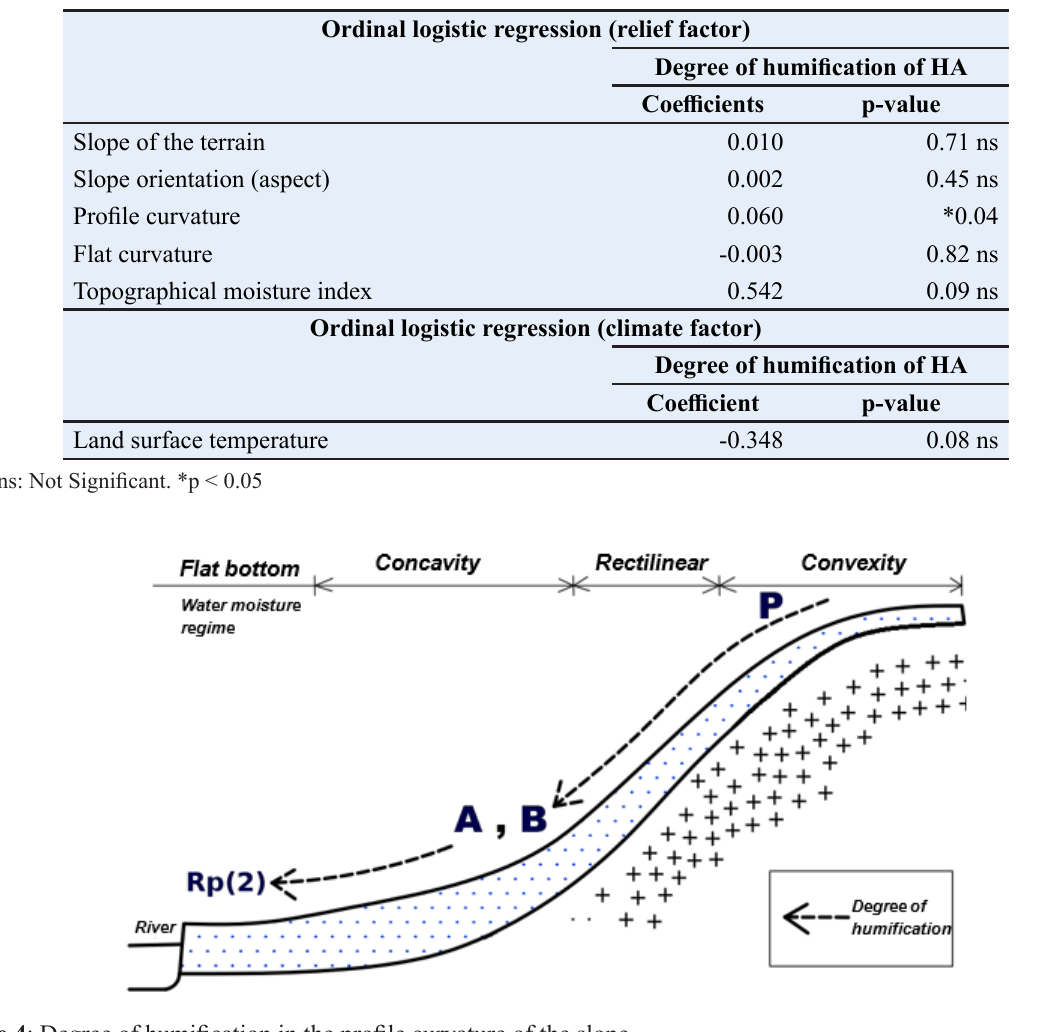
Table 3: Coefficients between the morphoclimatic variables and the degree of humification (p is the level of significance).